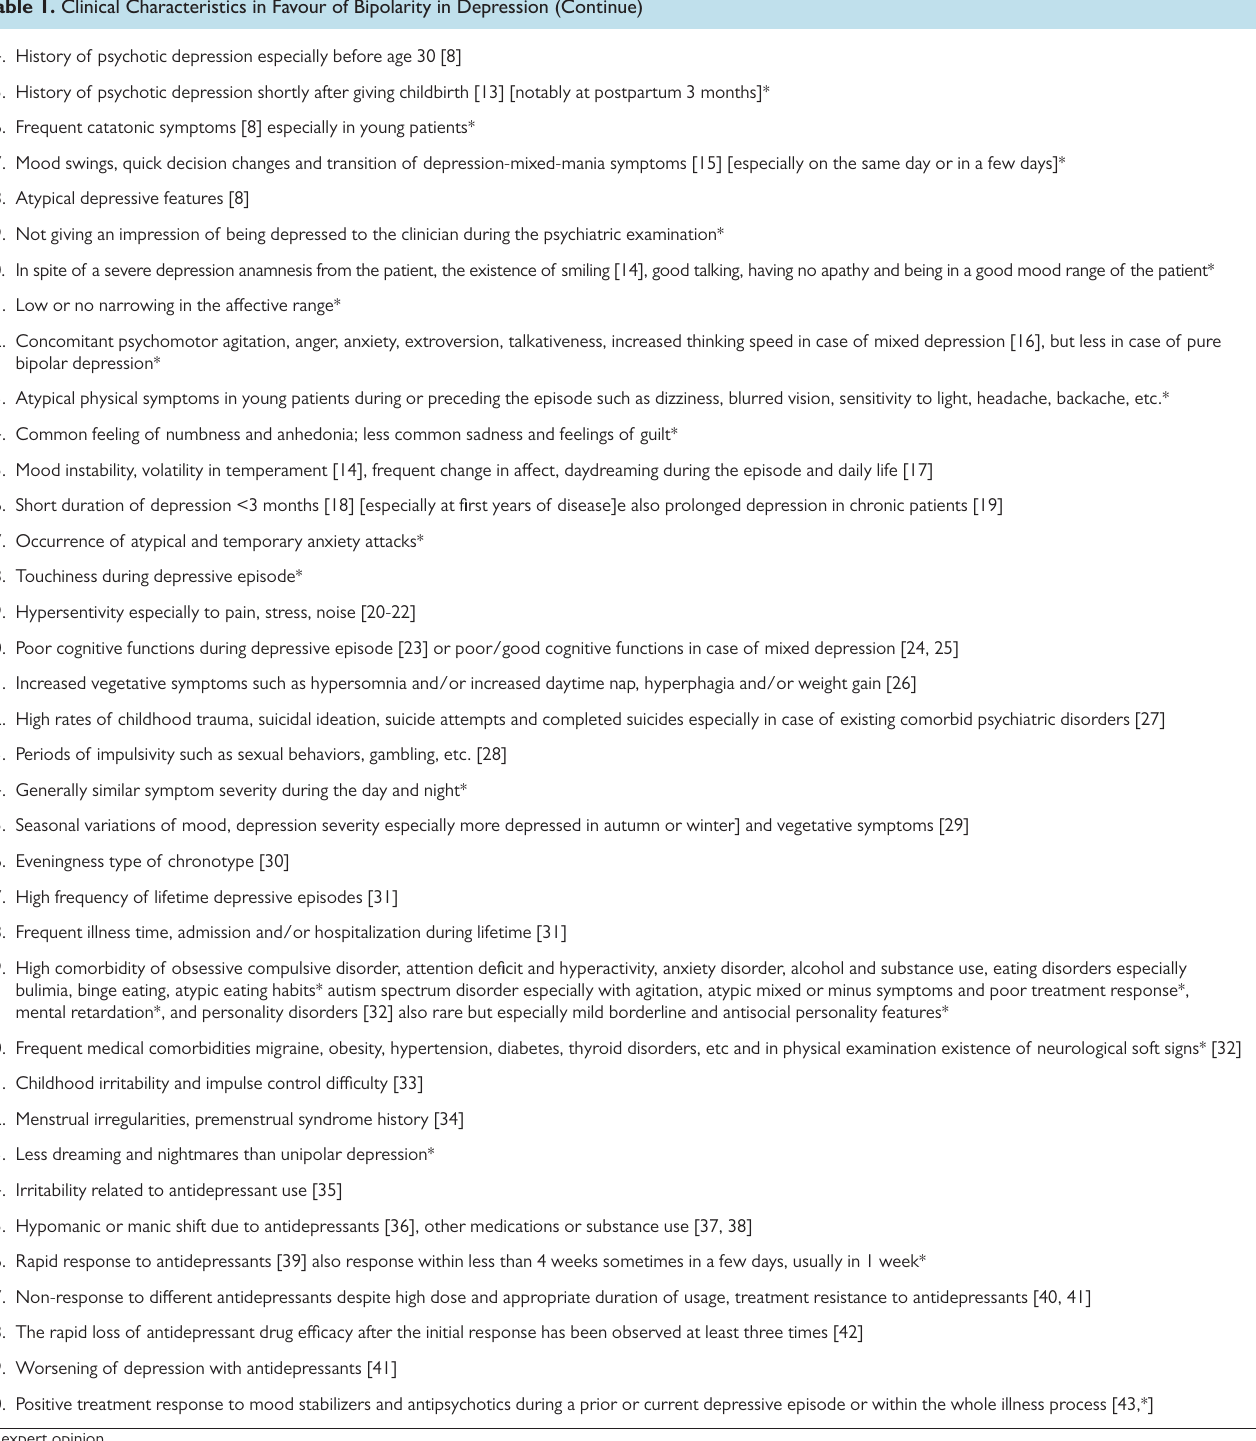
Table 1. Clinical Characteristics in Favour of Bipolarity in Depression